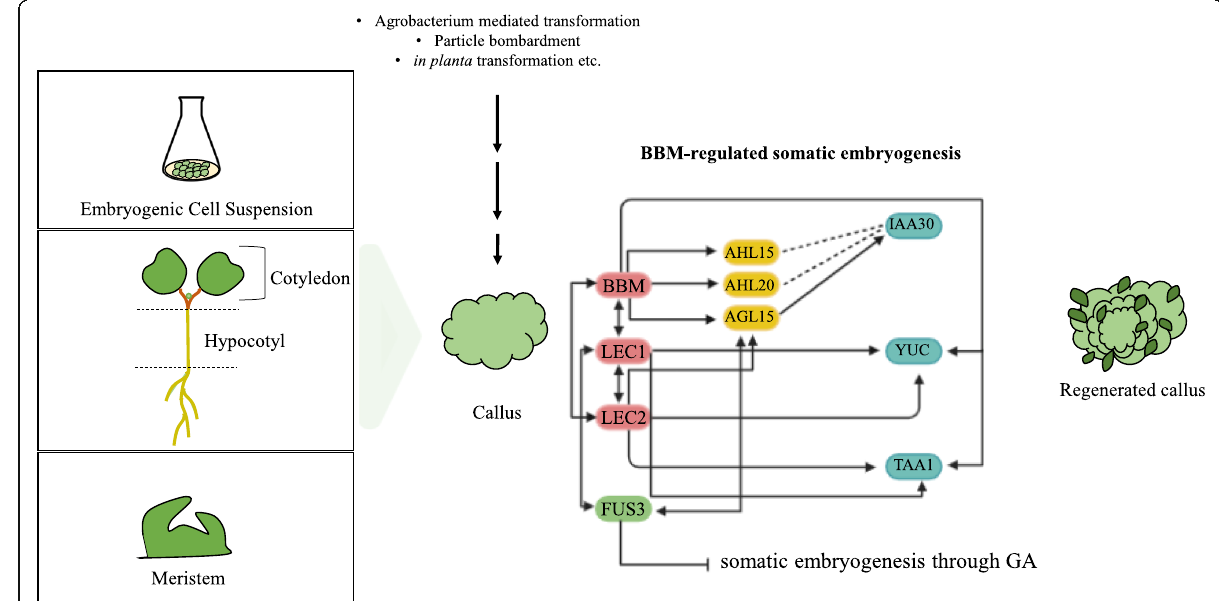
Fig. 2 Role of BBM gene during somatic embryogenesis. Solid arrows show the positive regulatory role whereas dashed lines represent the interaction of unexplored/undefined factor(s) between AHL15/AHL20 and IAA30. FUS3 interaction with GA has inhibitory effect on somatic embryogenesis. The figure has been conceptulized and drawn based on literatures reported by Wójcik et al. (2020), Wójcikowska et al. (2020), Jha et al. (2020) and Kumar and Jha (2020) using BioRender